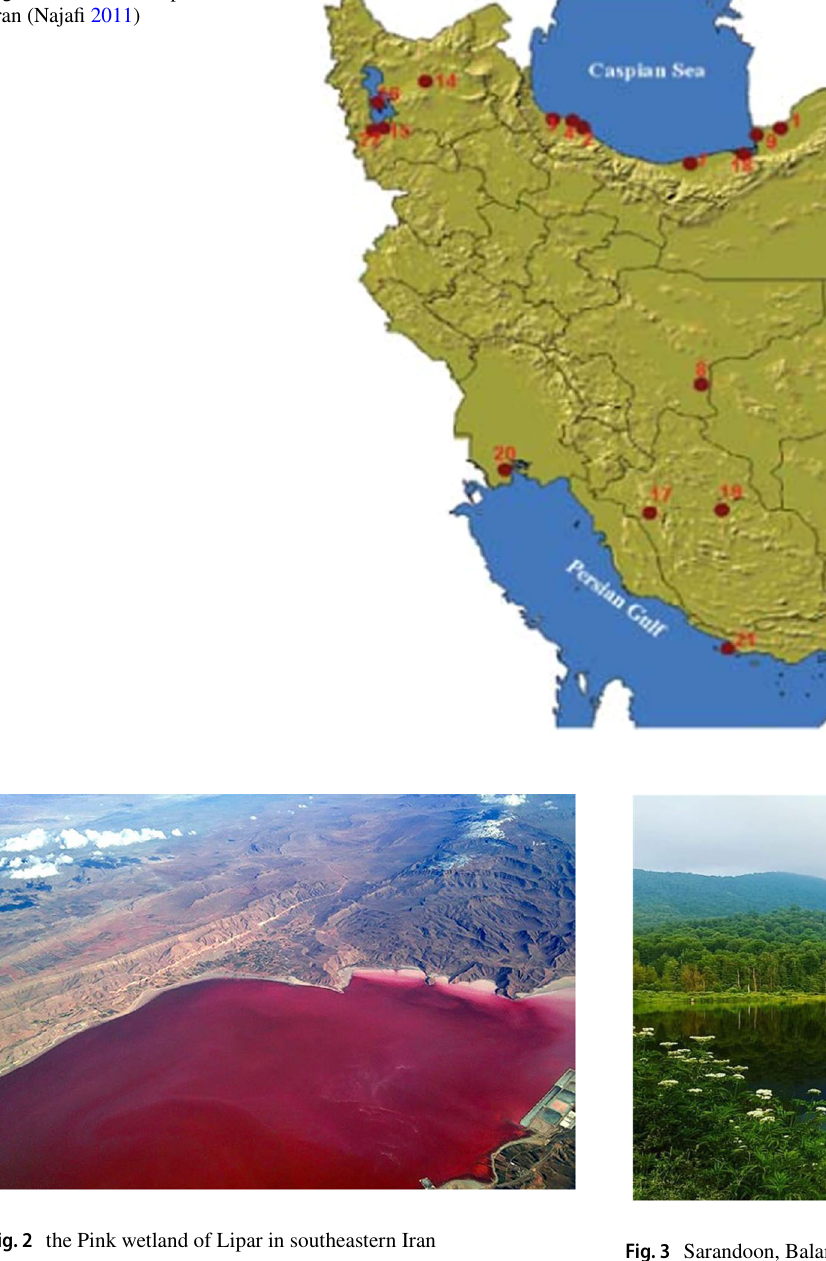
Fig. 1 The wetland’s position in Iran (Najafi 2011)